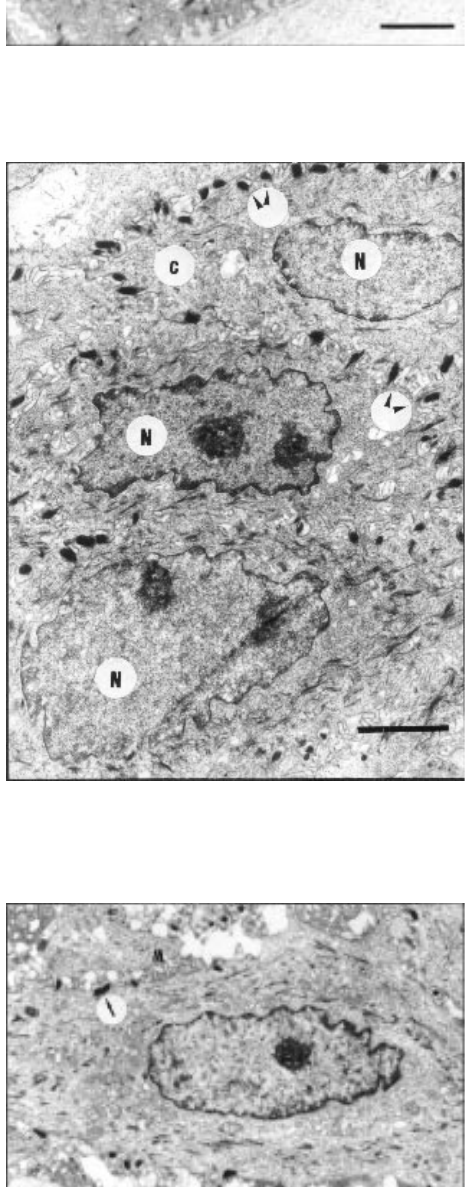
Figure 1 - Transmission electron micrograph of a reflected por- tion of amnion epithelium (e) showing cuboidal to low colum- nar cells with centrally located nuclei (N). Variable numbers of cytoplasmic lipid droplets are seen (L) as well as numerous microvilli projecting from the api- cal surface (mv). bl indicates the basal lamina and arrows indicate desmosomes. Lead citrate and uranyl acetate staining (bar = 1 µm).